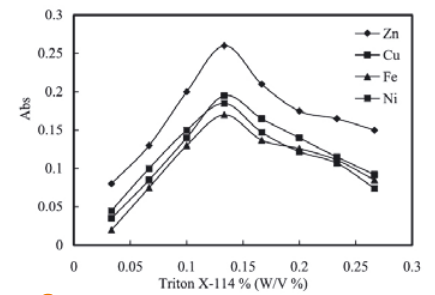
Figure 3. Effect of surfactant concentration on CPE of analyte ions